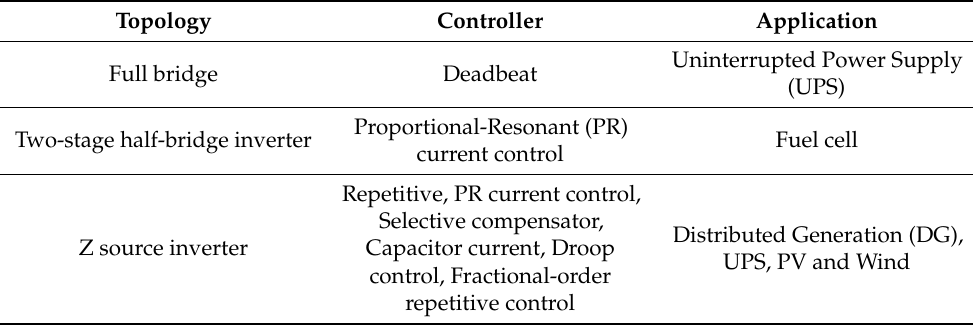
Figure 38. Smart inverter features. Table 6. Control techniques and their